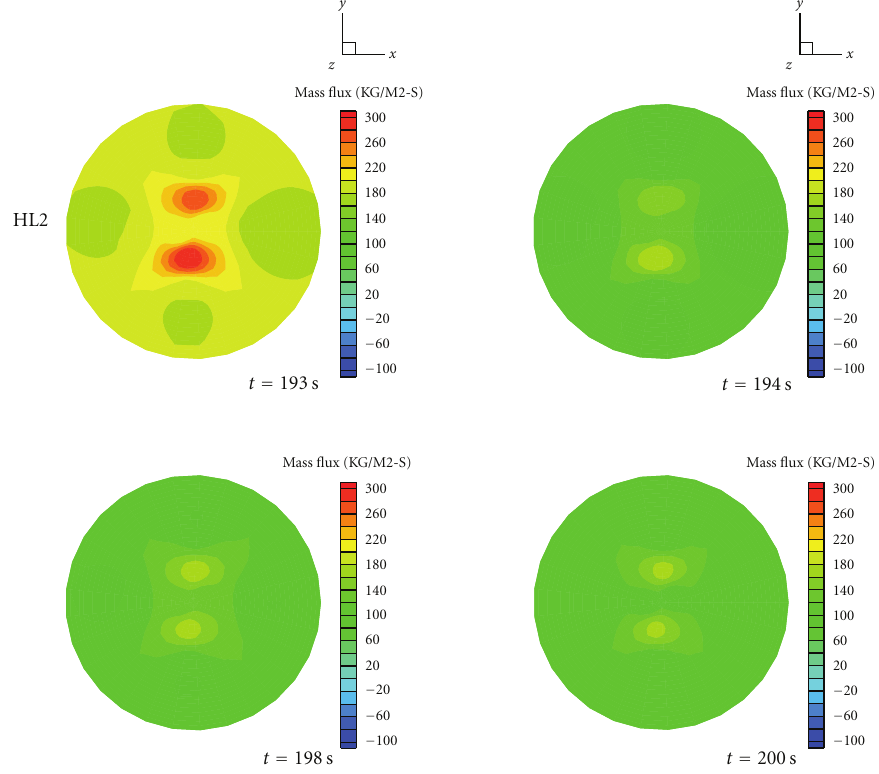
Figure 15: MARS-3D prediction of total mass flux at 11th elevation in the core, z = 1645 mm (SB-DVI-09).